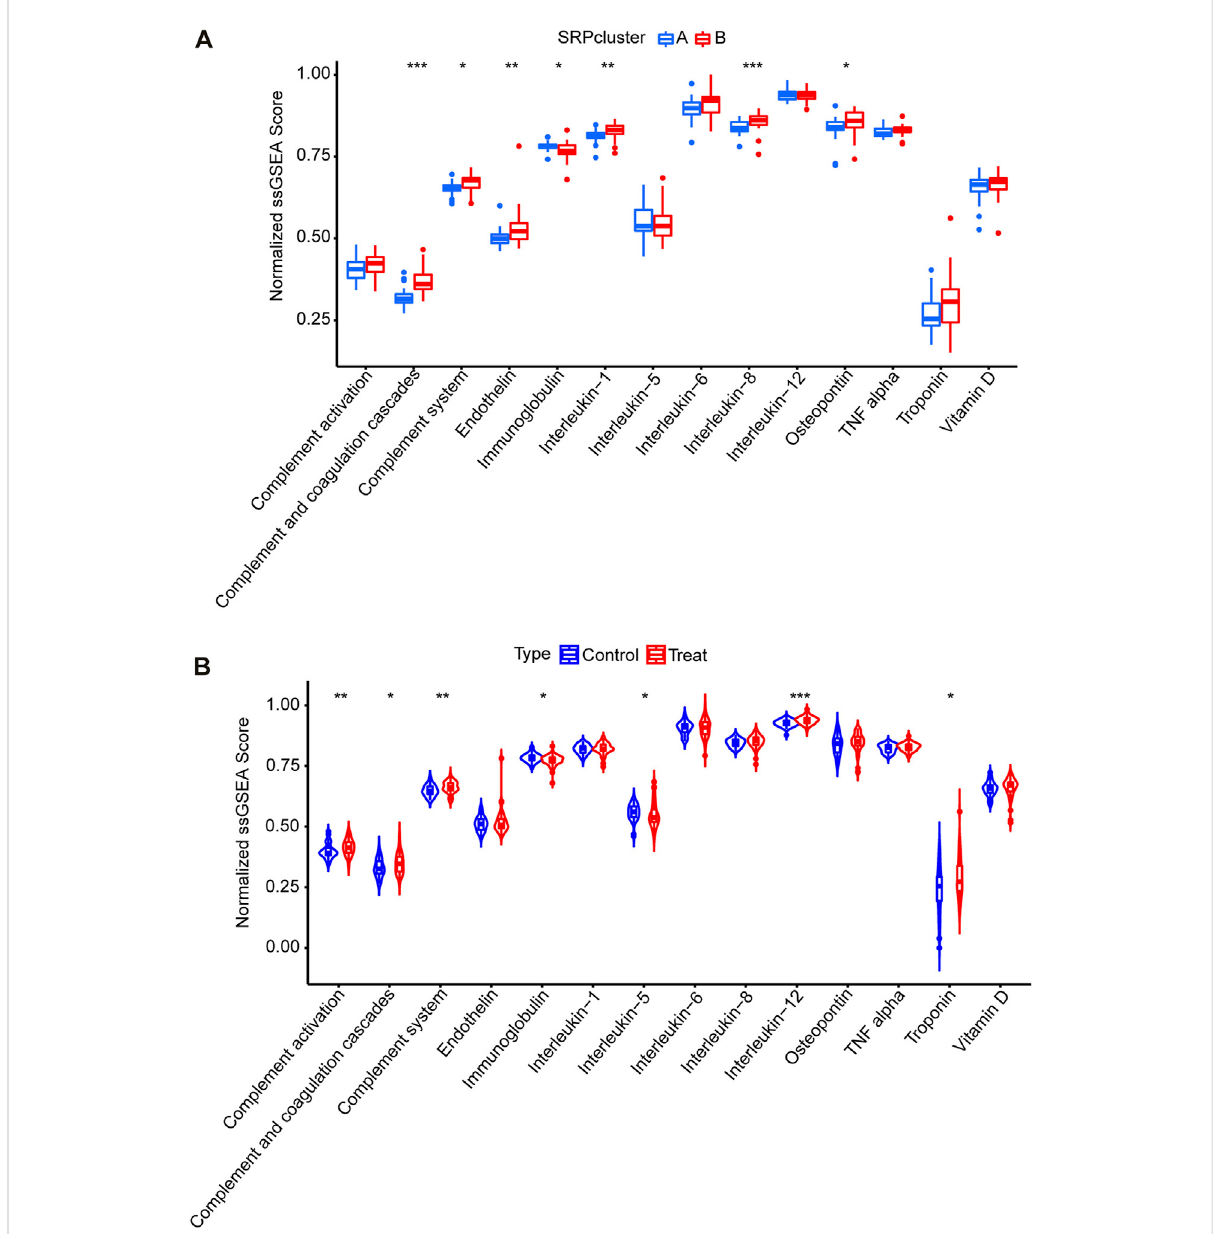
FIGURE 6 ssGSEA for14 SSc-PH-related pathways. (A) Comparison of normalized ssGSEA scores of 14 SSc-PH-related pathways between SRPcluster A and SRPcluster B. (B) Comparison of normalized ssGSEA scores of 14 SSc-PH-related pathways between treatment and control groups. *, p < 0.05; **, p < 0.01; ***, p <